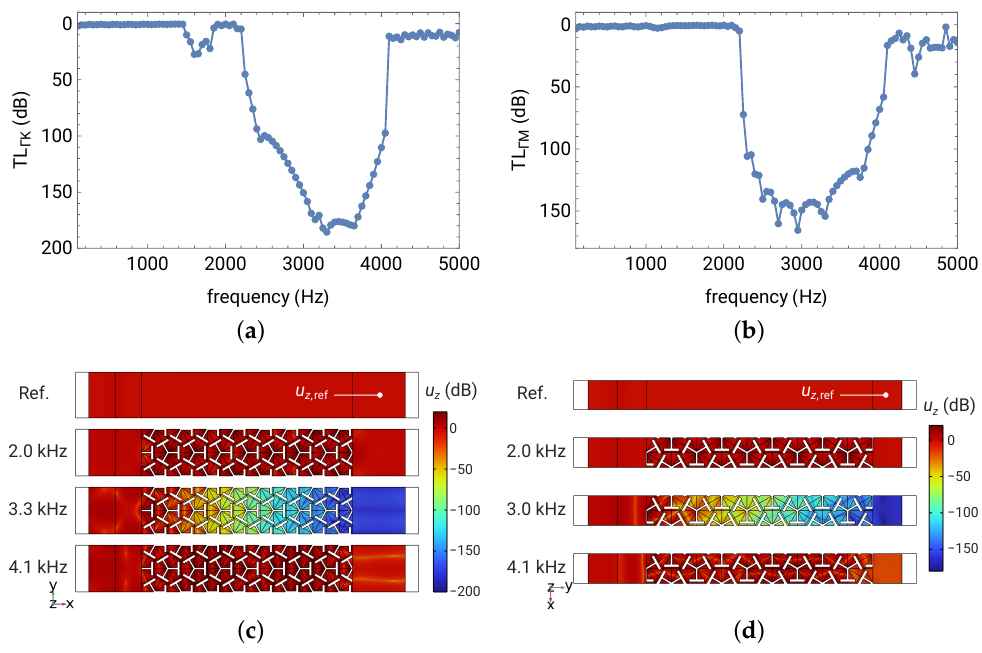
Figure 12. Transmission spectra and visualization of the designed metamaterial. ( a ) Transmission loss of flexural waves along Γ -K direction through the metamaterial of 8 a length. ( b ) Transmission √ loss along Γ -M direction through the metamaterial of 4.5 3 a length. ( c ) Visualization of flexural wave attenuation along Γ -K direction by plotting the u z -level in and outside the band gap. ( d ) The u z -level for flexural waves propagating in Γ -M direction. Figure 12c,d visualize the flexural wave attenuation by plotting the z -displacement amplitude | u z | in selected frequencies for both models. The color scheme utilizes dB scaling with the displacement amplitude of the reference model (homogeneous plate)